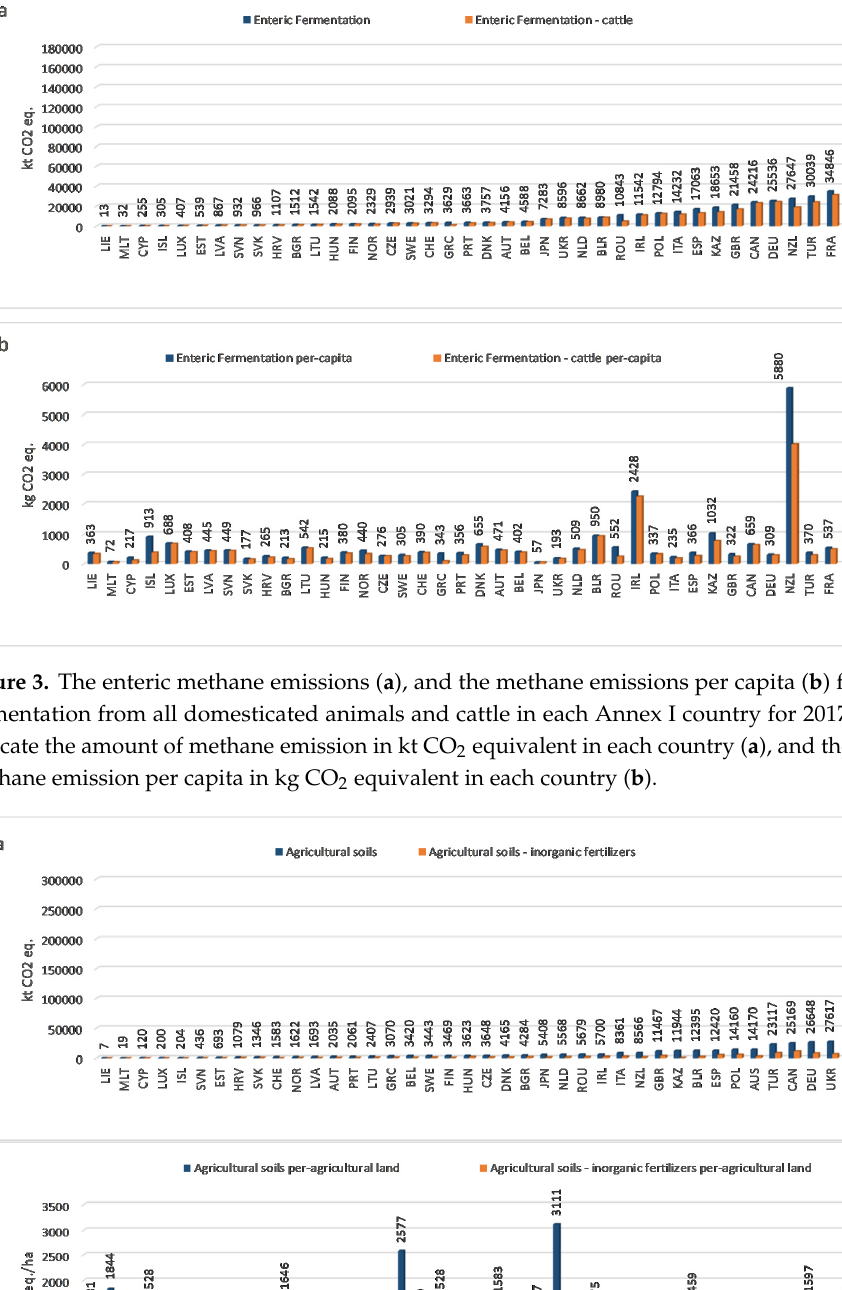
application) in agricultural emissions in each Annex I country for 2017.